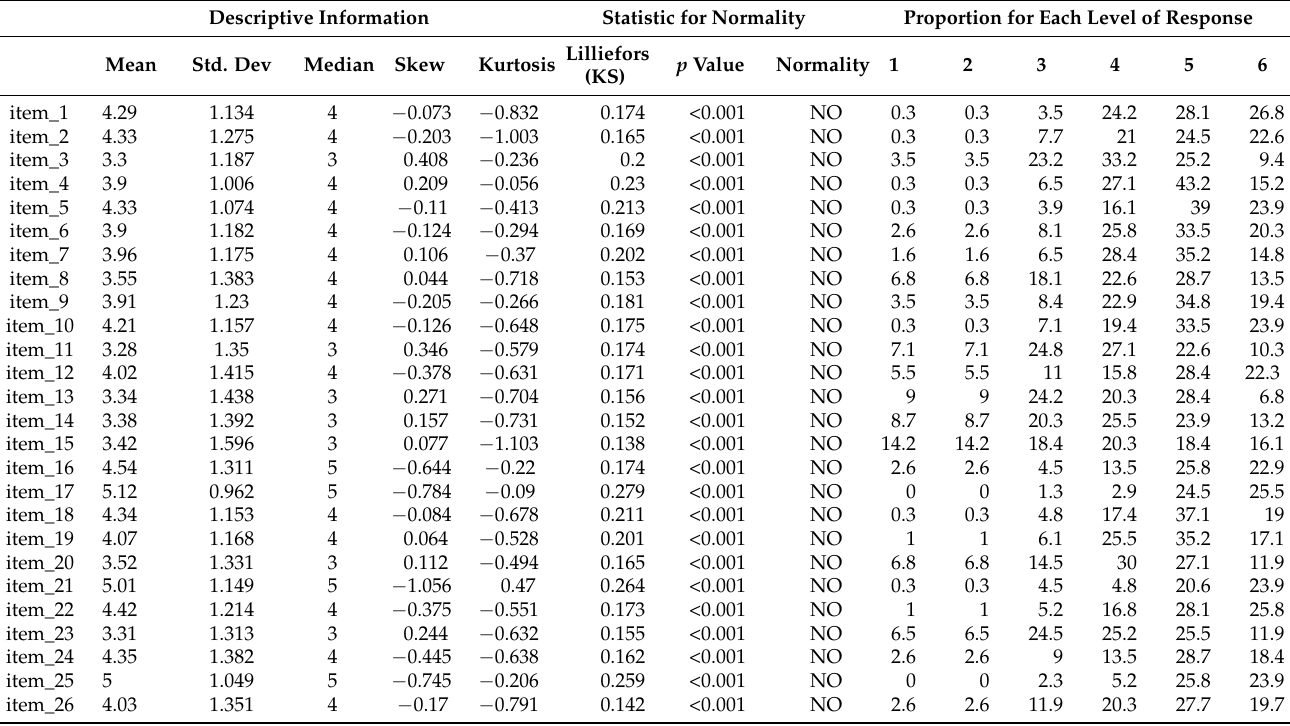
Table 1. Descriptive, Statistic of Normality, and Proportion for each level of response by